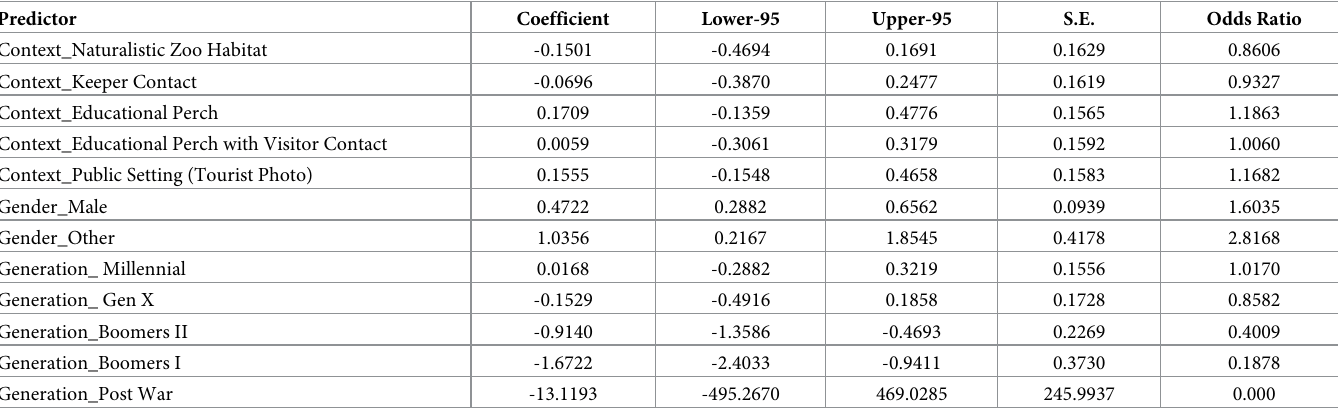
Table 4. Ordinal logistic regression results for the python experiment.